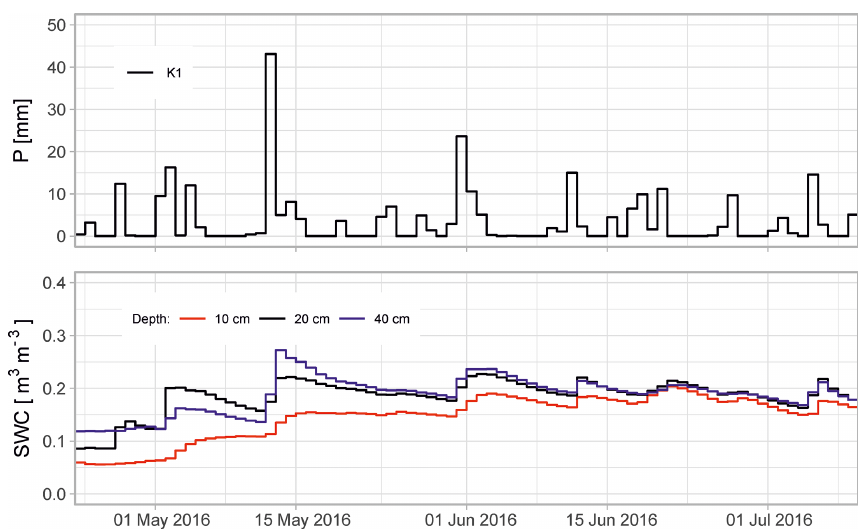
Figure 10. Detail of daily soil water content at site Q2S1: deeper sensors reacted faster to rainfall on 12 May 2016.